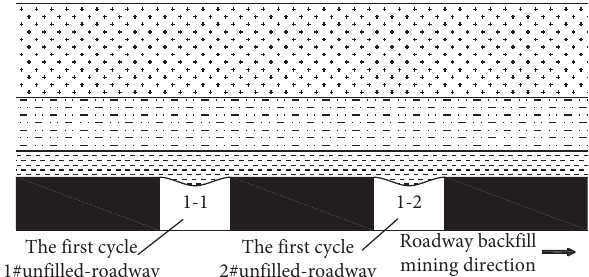
Figure 2: Schematic diagram of the first stage of strata movement.